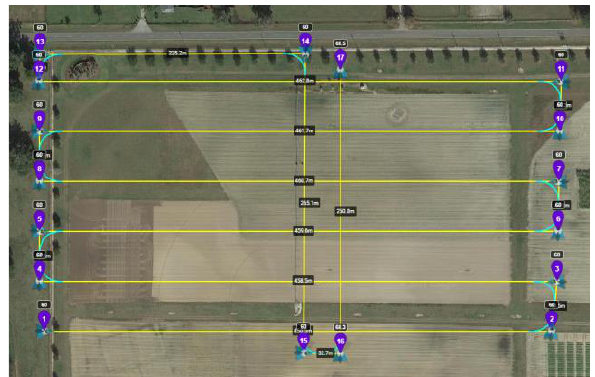
Figure 3. Overview of the 60 m AGL flight plan.